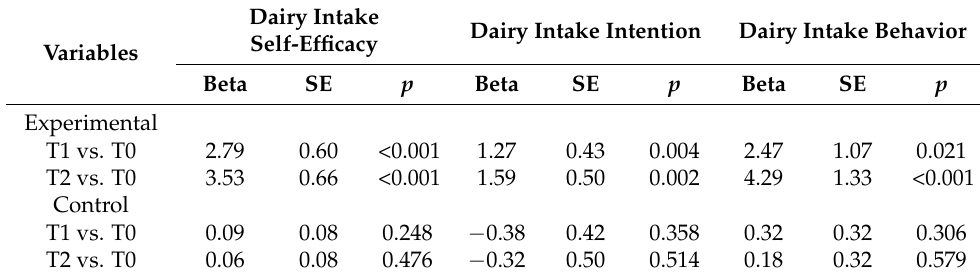
Table 3. The two groups’ outcome variables at pretest, post-1 week, and post-12 weeks ( n =